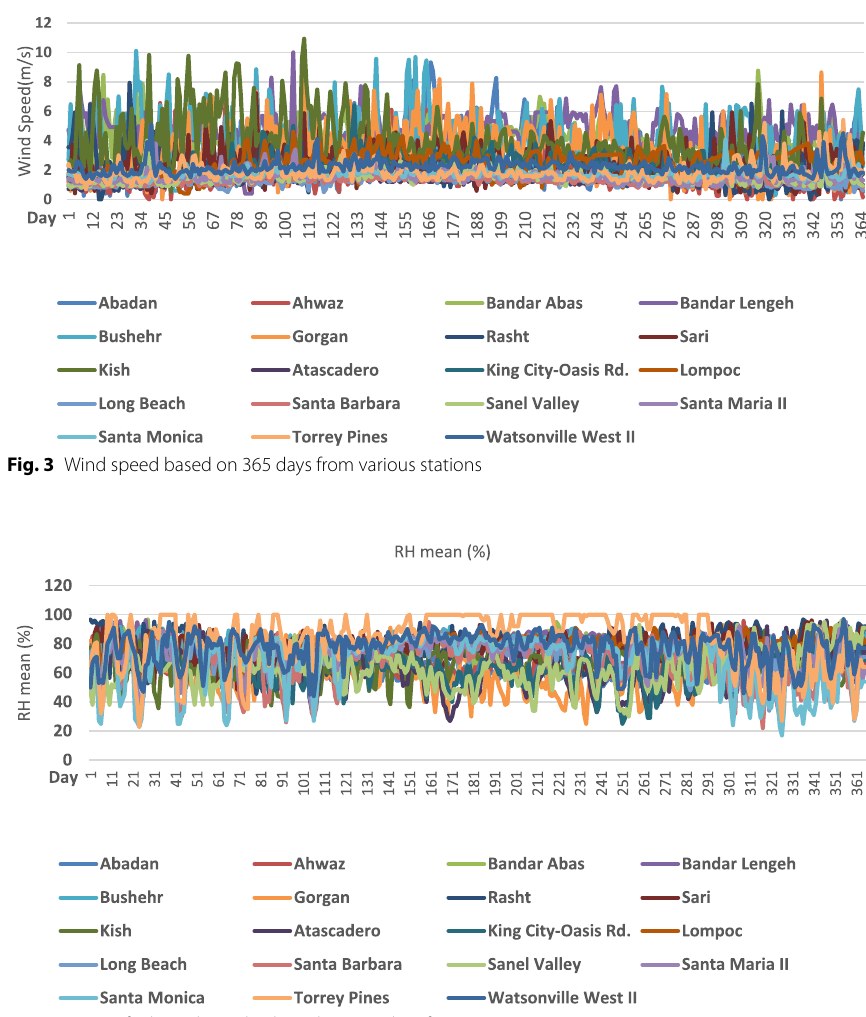
Fig. 4 Mean of relative humidity based on 365 days from various